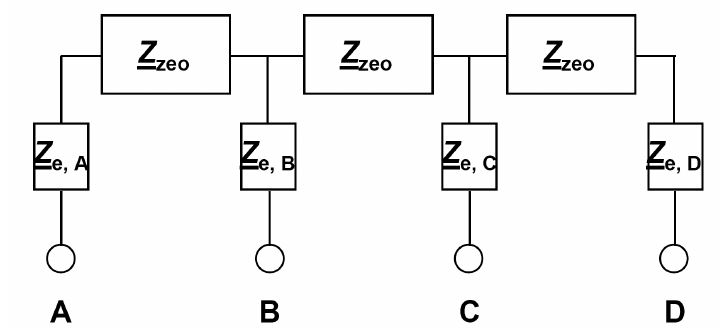
Figure 4. Simplified equivalent circuit of a planar four-wire transducer with zeolite thick-film